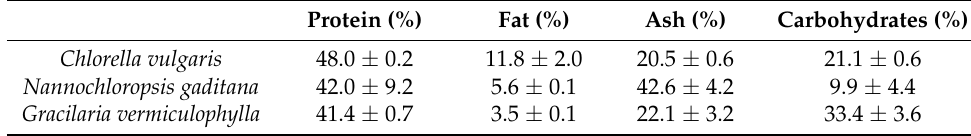
Table 2. Proximal composition of the algae extracts used in the present study.